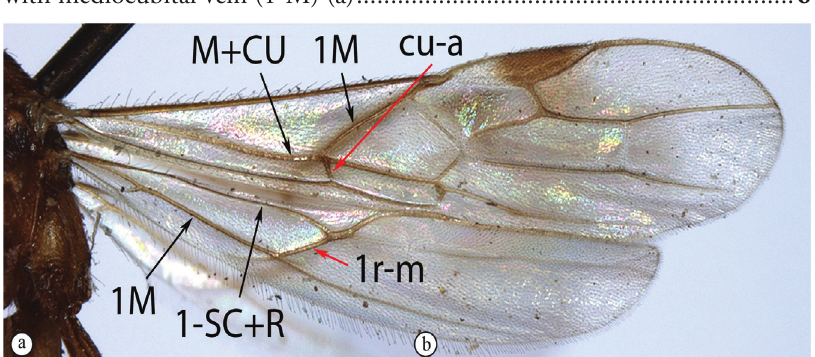
Precoxal sulcus absent (A). Metacarp (1-R1) of fore wing on outside margin almost without setae (B). Nervulus (cu-a) of fore wing strongly postfurcal to